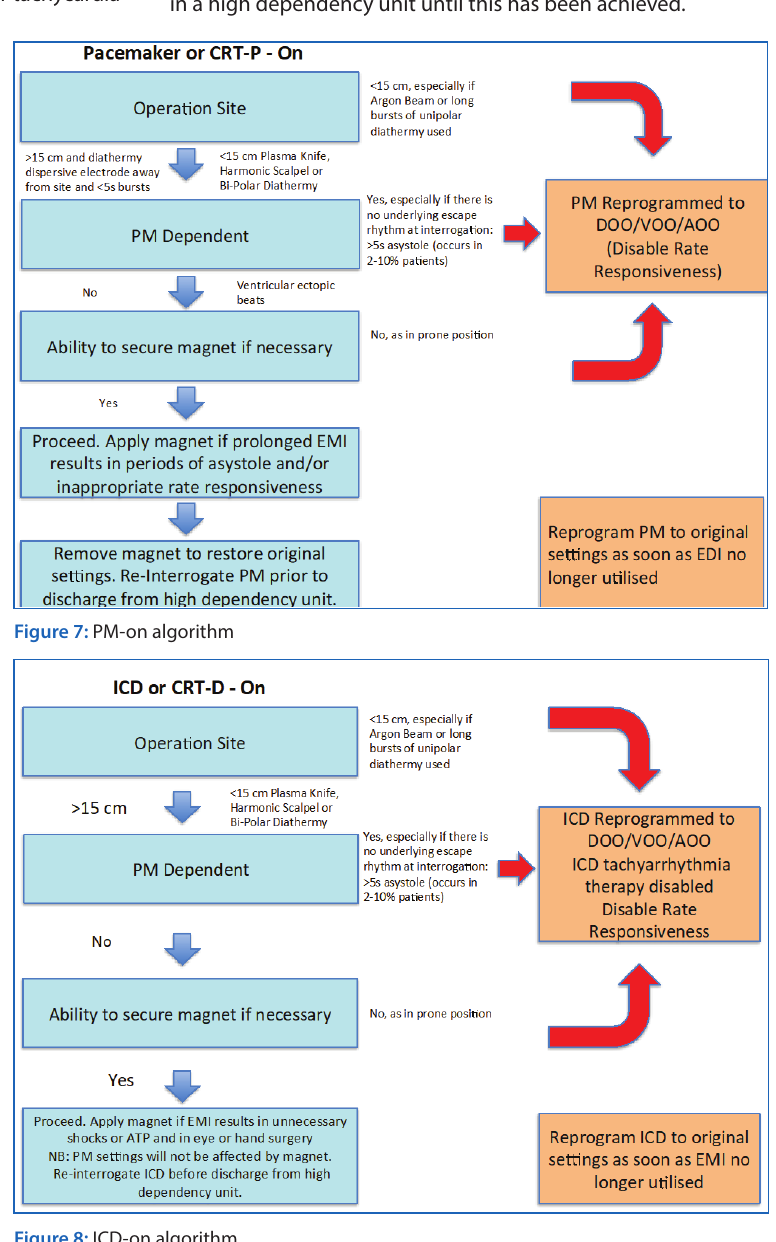
Figure 8: ICD-on Figure 8: ICD-on algorithm References